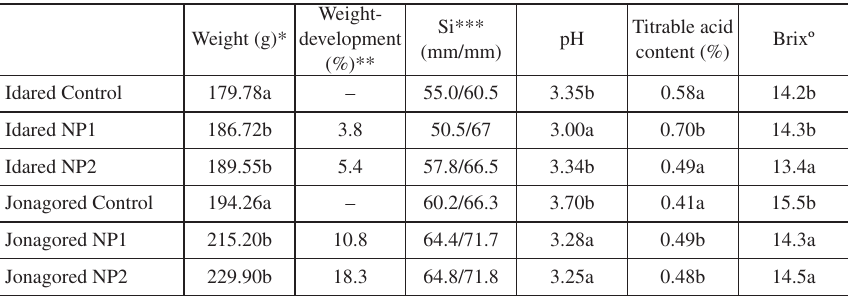
Table 4. Results of fruit